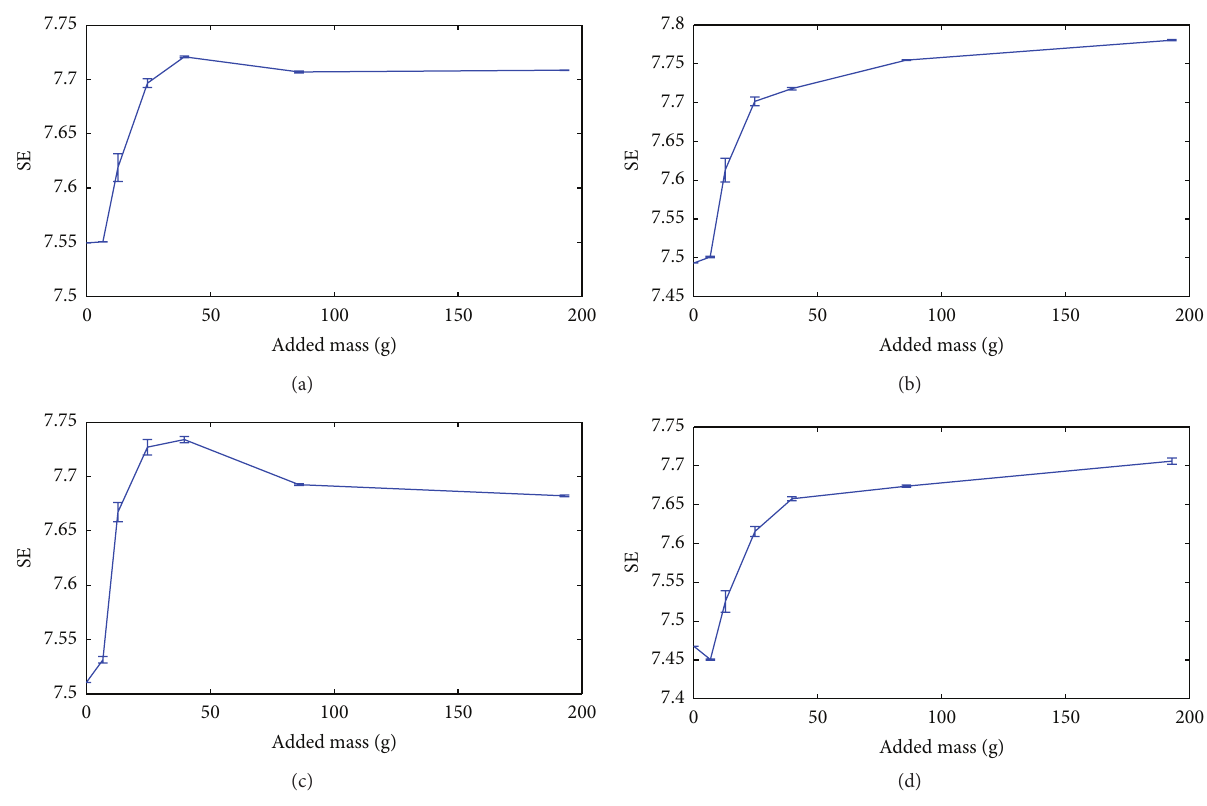
Figure 8: Variation of SE with the added mass in position 3 for (a) Sensor S1; (b) Sensor S2; (c) Sensor S3; (d) Sensor